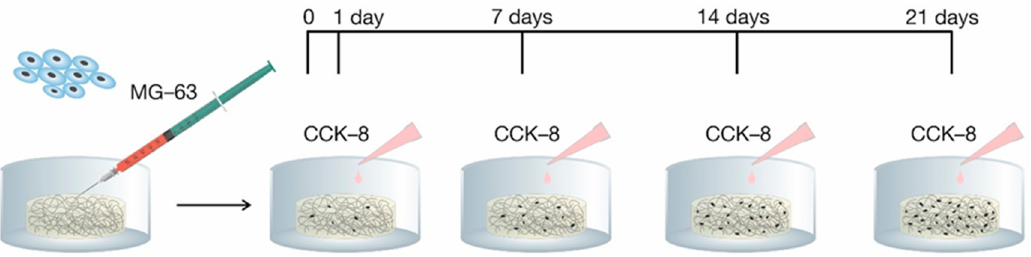
Figure 1. Timeline of adhesion and proliferation monitoring. CCK-8 is Cell Counting Kit-8.